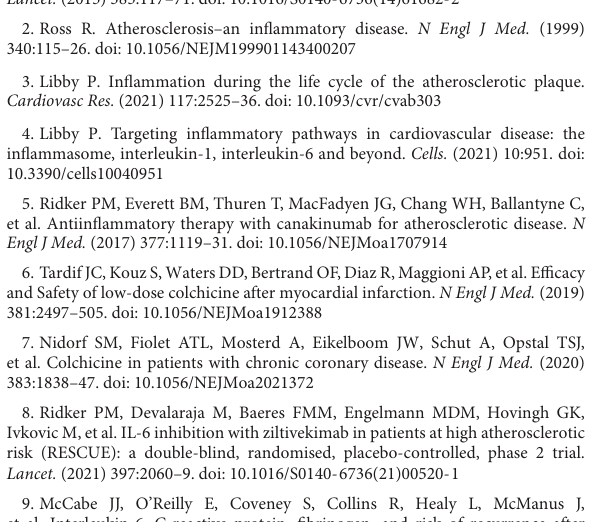
SUPPLEMENTARYFIGURES1 Plasma levels of sPD-L1 between CAD patients and HCs of different ages. Patients between 30 and 50 years old with CAD ( n = 29) and HCs ( n = 39); patients between 51 and 75 years with CAD ( n = 82) and HCs ( n = 58). *** p < 0.001, ** p < 0.01. sPD-L1, soluble form of programmed cell death ligand-1; CAD, coronary artery disease; HCs, healthy controls. SUPPLEMENTARYFIGURES2 Association analysis of sPD-L1 with IFN- γ in UA ( n = 22). SUPPLEMENTARYFIGURES3 Standard curve of the novel sandwich ELISA for sPD-L1. The capture antibody 11E3 and detection antibody Bio2F1 were followed by HRP-streptavidin to amplify the signal. The sensitivity of the detection system reached approximately 0–5 pg/ml. The error bars represent the SDs. SUPPLEMENTARYFIGURES4 Comparison of ROC curves between our sPD-L1 ELISA and a commercial sPDL1 kit for the diagnostic value of sPD-L1 in ACS. The area under the curve (AUC) of sPD-L1 in ACS ( n = 76) using our sPD-L1 ELISA was 0.736, with a sensitivity of 76.3% and a specificity of 73.8%. In addition, the AUC of the commercial sPDL1 kit was 0.604, indicating a sensitivity of 60.5% and a specificity of 57.4% for the same ACS patients. SUPPLEMENTARYTABLES1 Baseline characteristics of 111 enrolled CAD